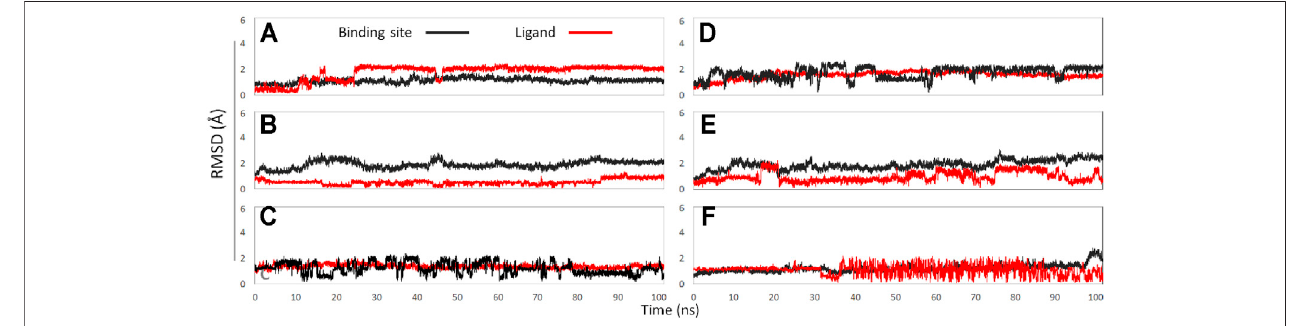
FIGURE 8 | The RMSD values of binding sites (black line) and ligand (red line): (A) GAS in Site 1; (B) GAS in Site 2; (C) GAS in Site 3; (D) GAS in Site 4; (E) GAS in Site 5; (F) GAS in Site 6.